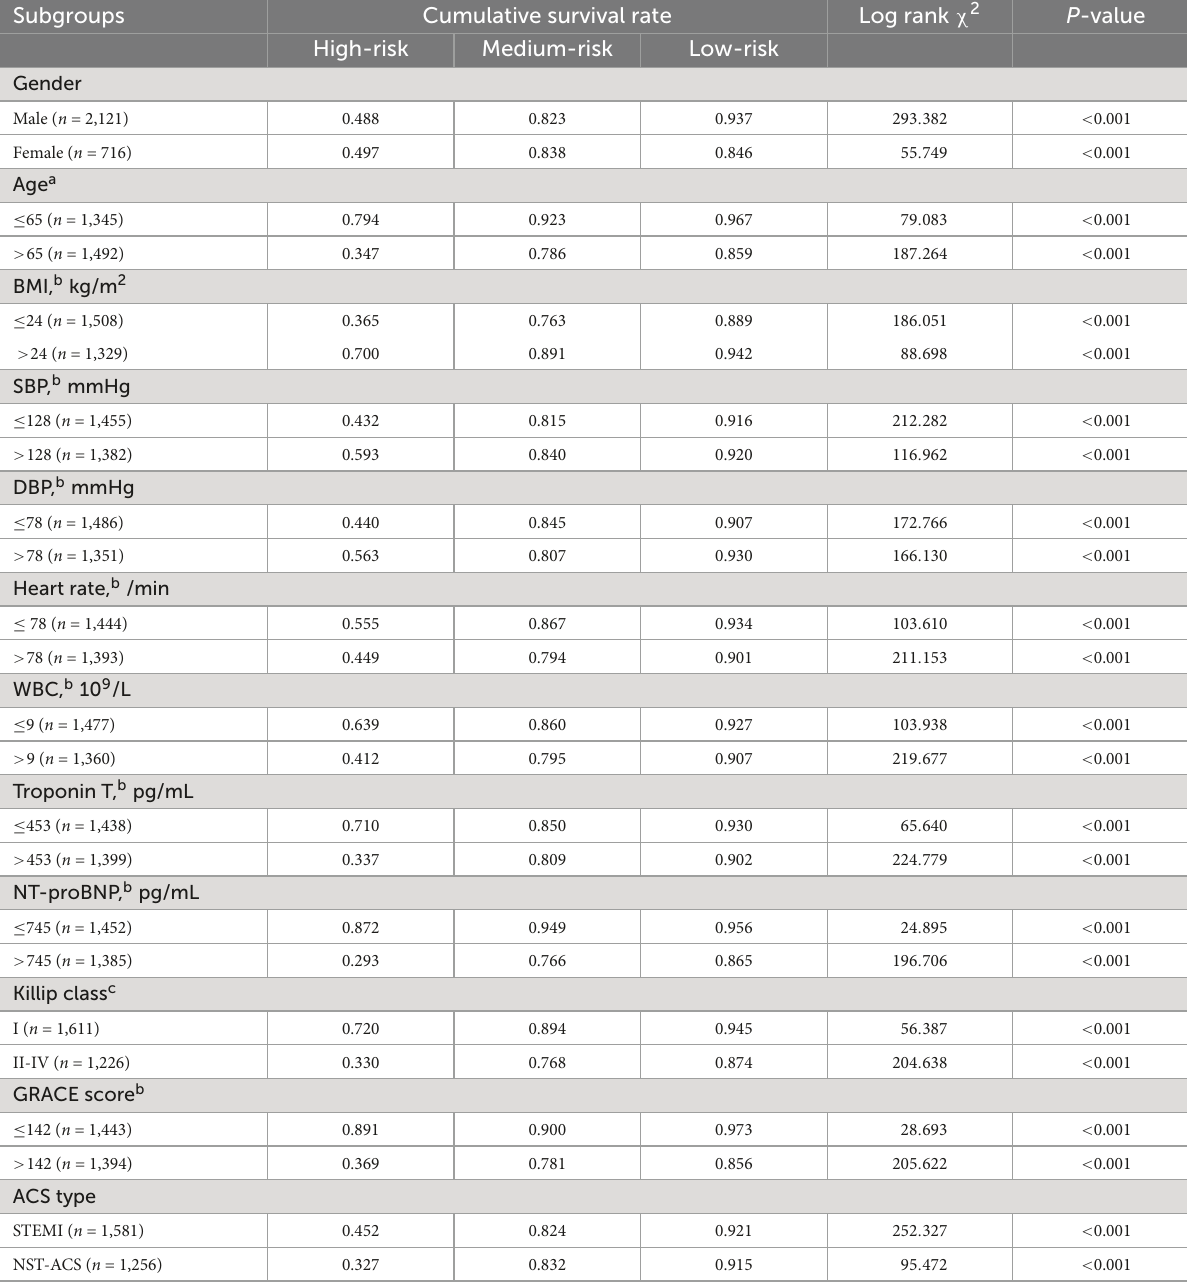
TABLE 4 Kaplan–Meier survival analysis of mortality in acute coronary syndrome